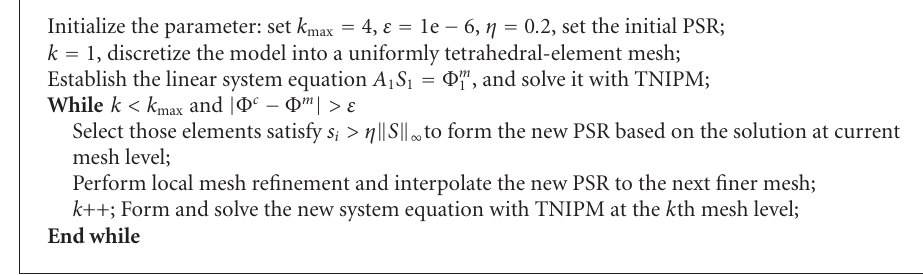
Algorithm 2: Multilevel l 1 -regularized reconstruction